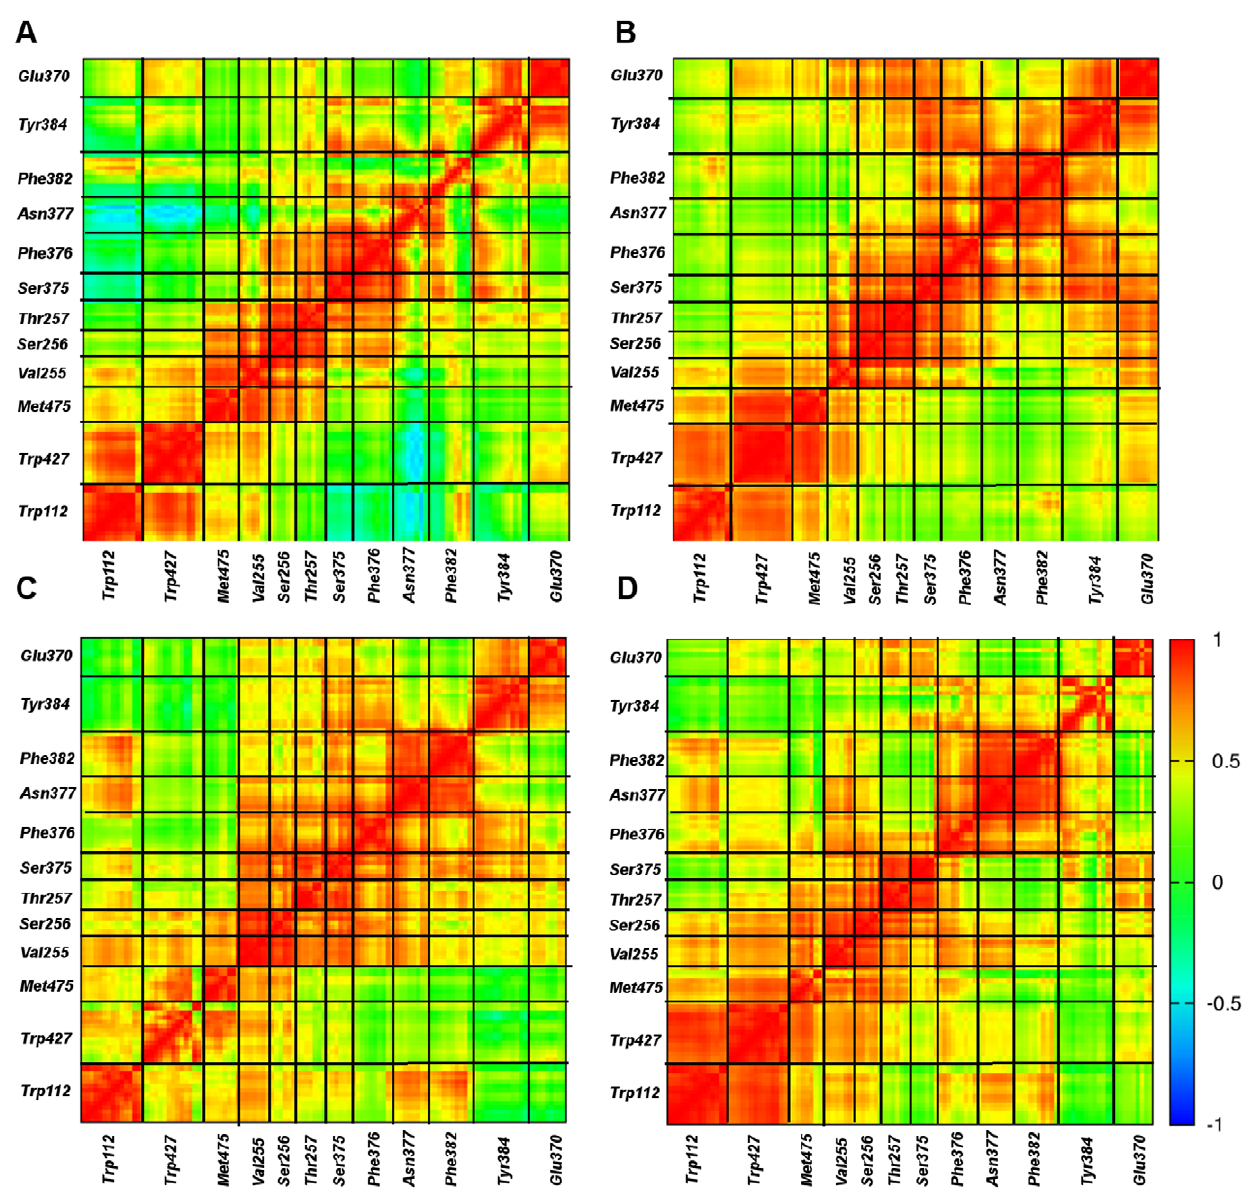
Figure 8. Cross correlations of fluctuations of conserved residues lining the Phe43 cavity. The cross correlation values are based on the sum of the 10 slowest modes. ( A ) gp120. ( B ) gp120:CD4(D1). ( C ) gp120:F23. ( D ) gp120:CD4M33. Specific residues are identified in the same order as in Fig. 7B.